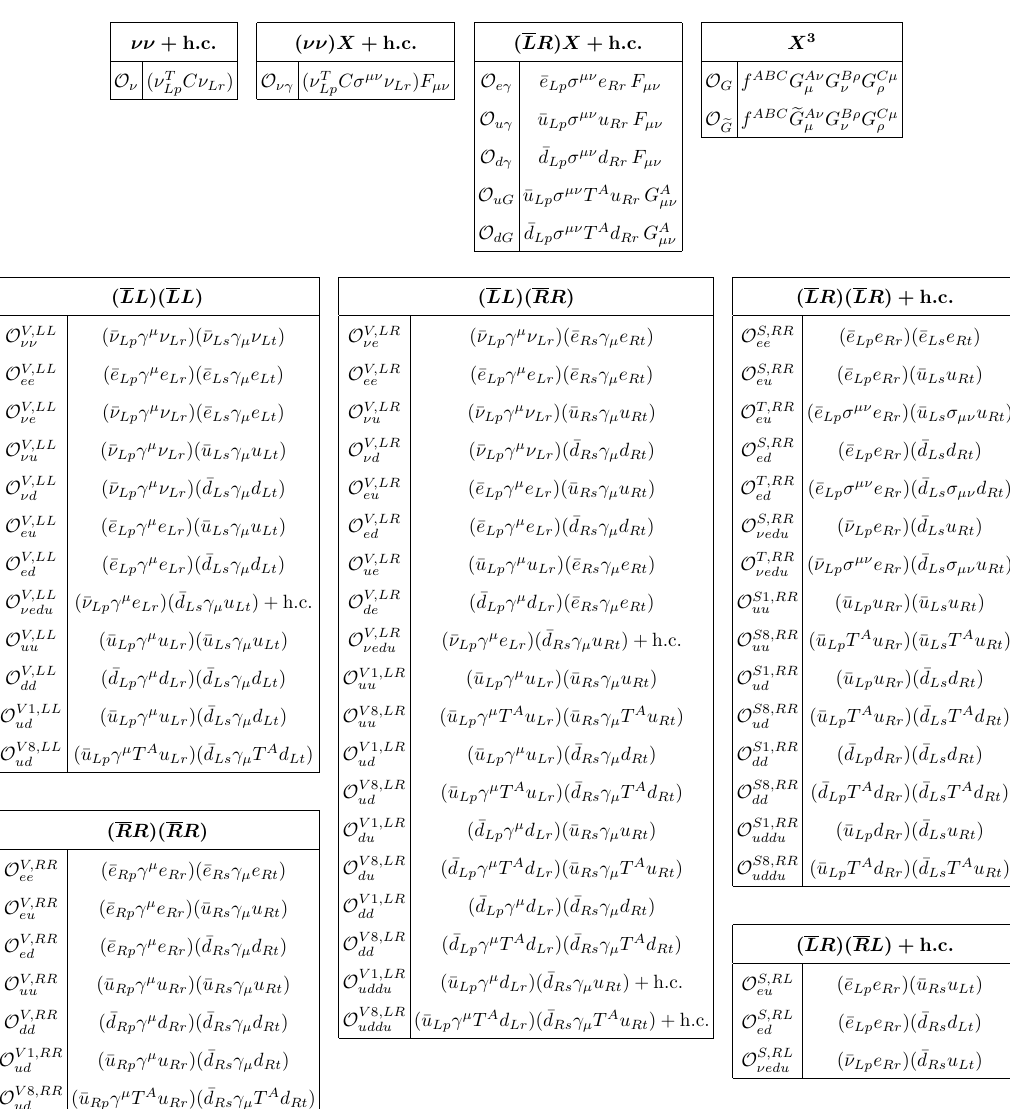
Table 3 . LEFT operators of dimension three and (cid:12)ve, as well as LEFT operators of dimension six that conserve baryon and lepton